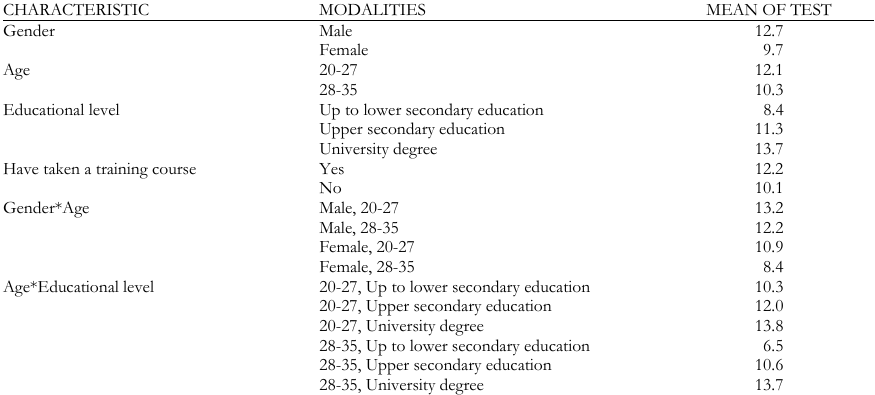
Analysis of variance test results for characteristics with significant differences between group means